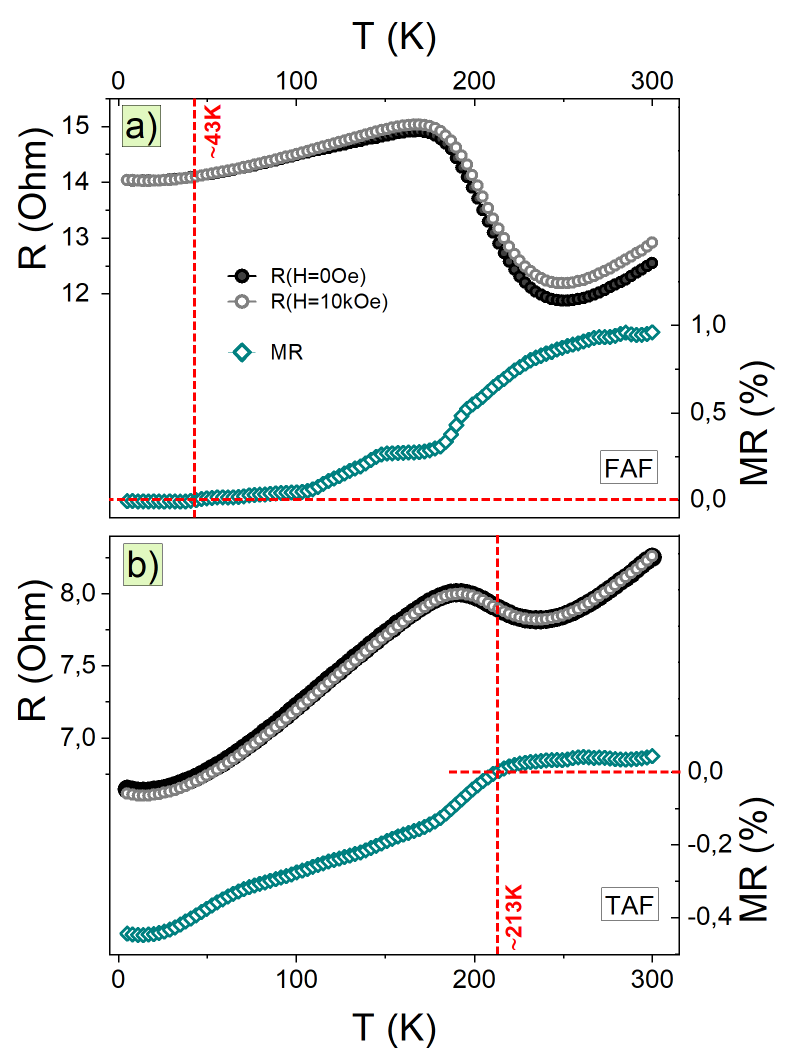
Figure 8. Temperature dependent resistivity R ( T ) measured without and with a magnetic field of 10 kOe and corresponding magnetoresistance values for ( a ) FAF and ( b ) TAF